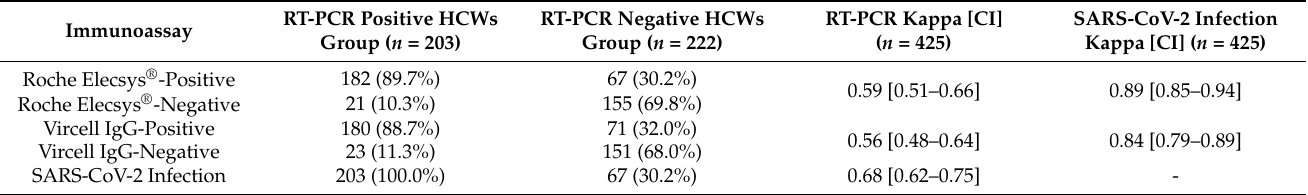
Table 3. Roche Elecsys ® and Vircell IgG performance among HCWs in the RT-PCR group from the study cohort ( n = 425).